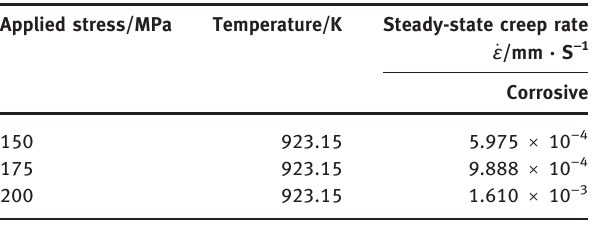
Table 4: Steady-state creep rates of corrosive specimens at different applied stresses. Applied stress/MPa